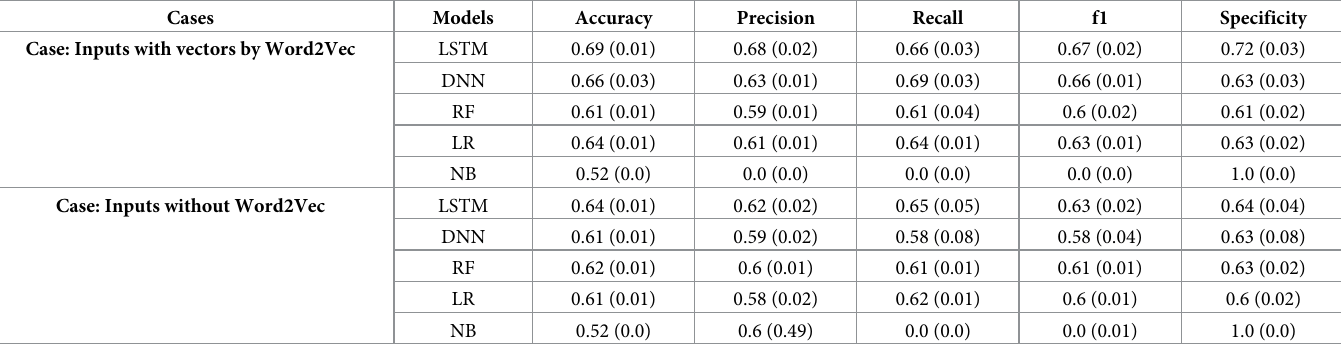
Table 4. Model performance by metrics of 5-fold cross-validation mean (std).